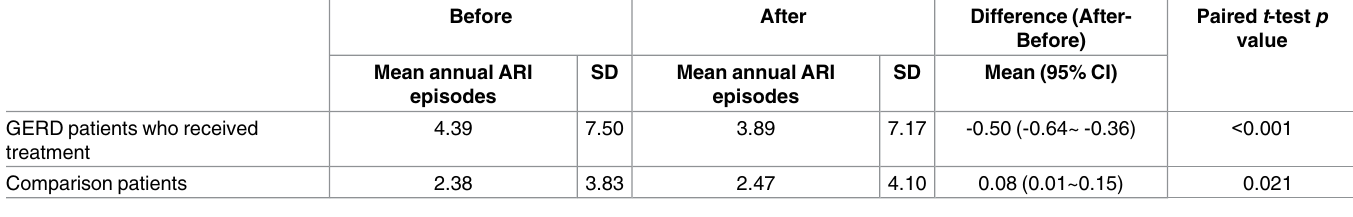
Table 2. Number of annual episodes of acute respiratoryinfection per patient during the year before and after the index date, among study patients (with gastroesophageal reflux disease, GERD) and comparison patients. Before